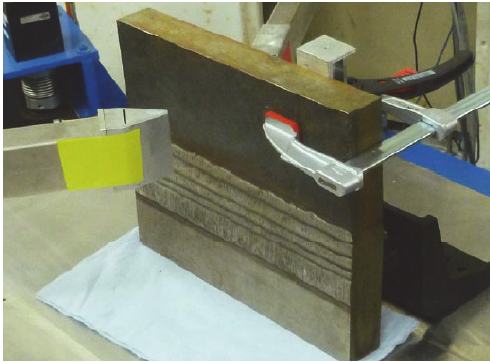
Figure 7: Section of Mock-up on diffractometer.